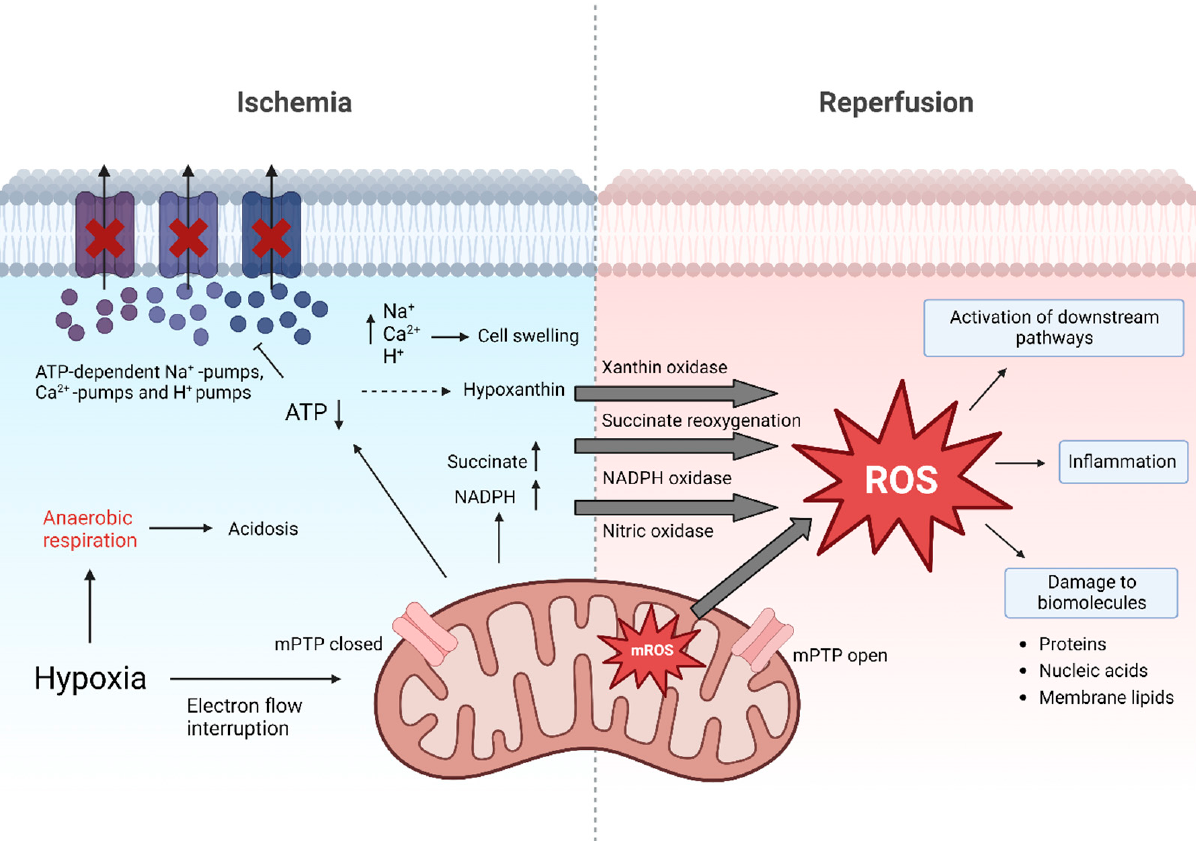
Figure 1. Molecular events of ischemia and reperfusion. During ischemia, adenosine triphosphate (ATP) levels decrease. In turn, ATP-dependent Ca2+, H+ and Na+ pumps fail, causing accumulation of ions which contributes to cell swelling. pH levels decrease leading to acidosis. Accumulation of succinate, nicotinamide adenine dinucleotide phosphate (NADPH; resulting from NADP+ and H+) and hypoxanthine during ischemia prime for excessive ROS release after reperfusion. Additionally, in mitochondria major reactive oxygen species (ROS) generation occurs. ROS cause direct damage to biomolecules but also act as signaling molecule. Besides this, opening of the mitochondrial permeability transition pore (mPTP) during reperfusion also triggers cell death by release of cytochrome c and breakdown of ATP production [5,16].